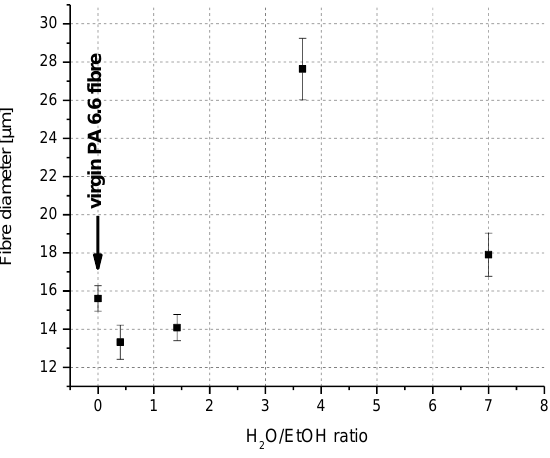
Figure 7. Fibre diameter as a function of H 2 O/EtOH ratios in CaCl 2 /H 2 O/EtOH mixtures after 10 min treatment.